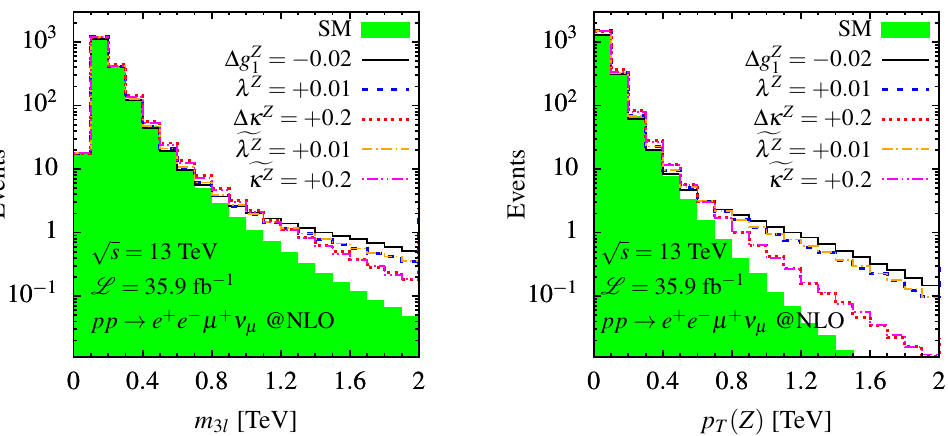
+ Z production in the e + e + (cid:23) (cid:0) (cid:22) 3 l and p T ( Z ) in the W (cid:22)